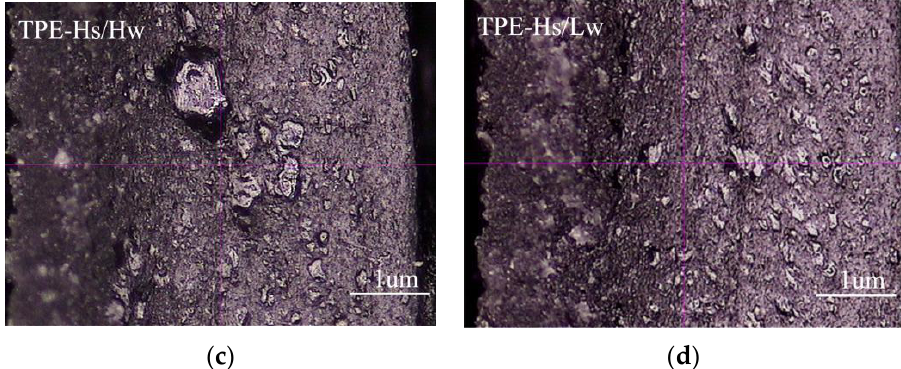
Figure 6. Comparison of abrasion scars of TPE with high styrene content. ( a , b ) are the pictures of TPE-Hs/Hw and TPE-Hs/Lw magnified 40 times respectively, ( c , d ) are partial magnifications of ( a , b ) with a magnification of 200 times).